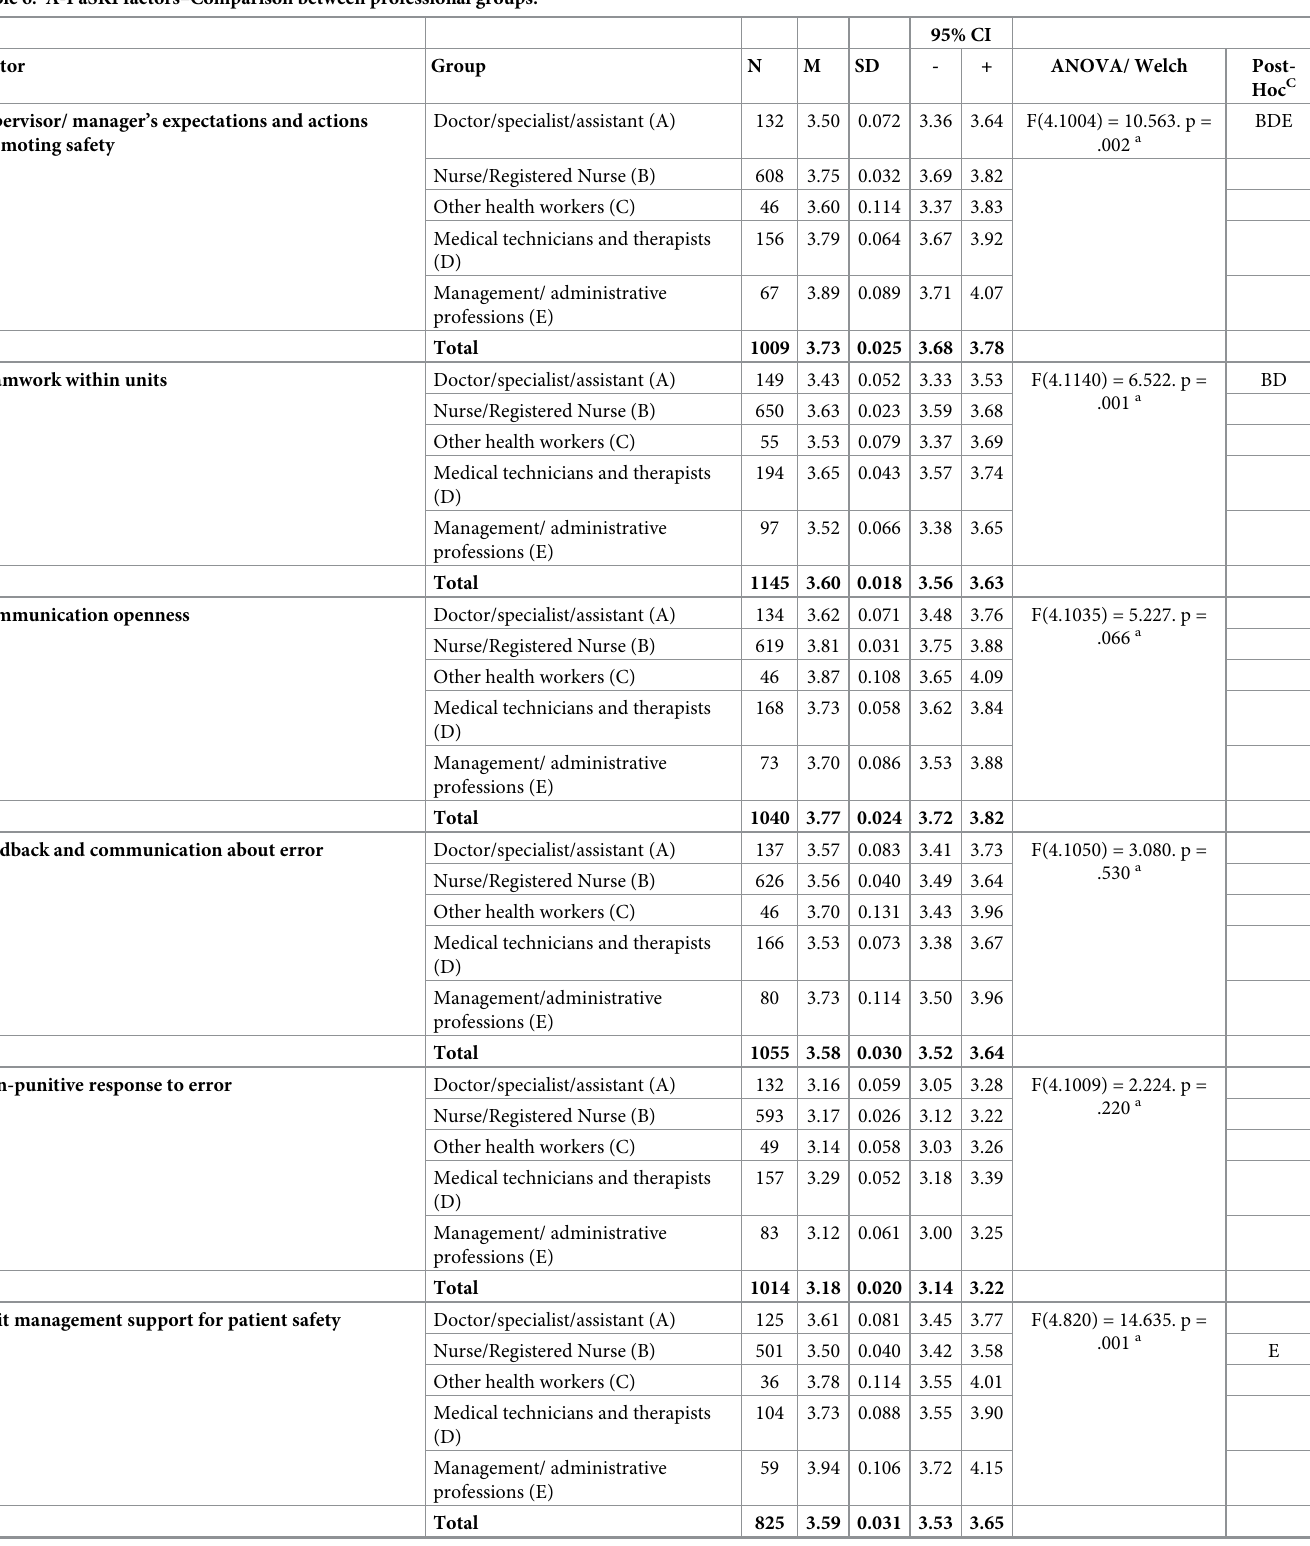
Table 6. A-PaSKI factors–Comparison between professional